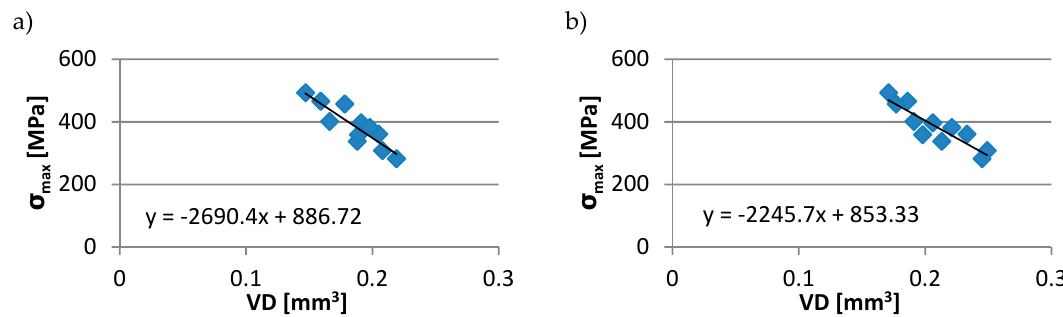
Figure 9. Dependency between disc volumetric wear VD and maximum value of stresses in the surface layer σ max at the sliding speed of: ( a ) 0.16 m/s; ( b ) 0.48 m/s.